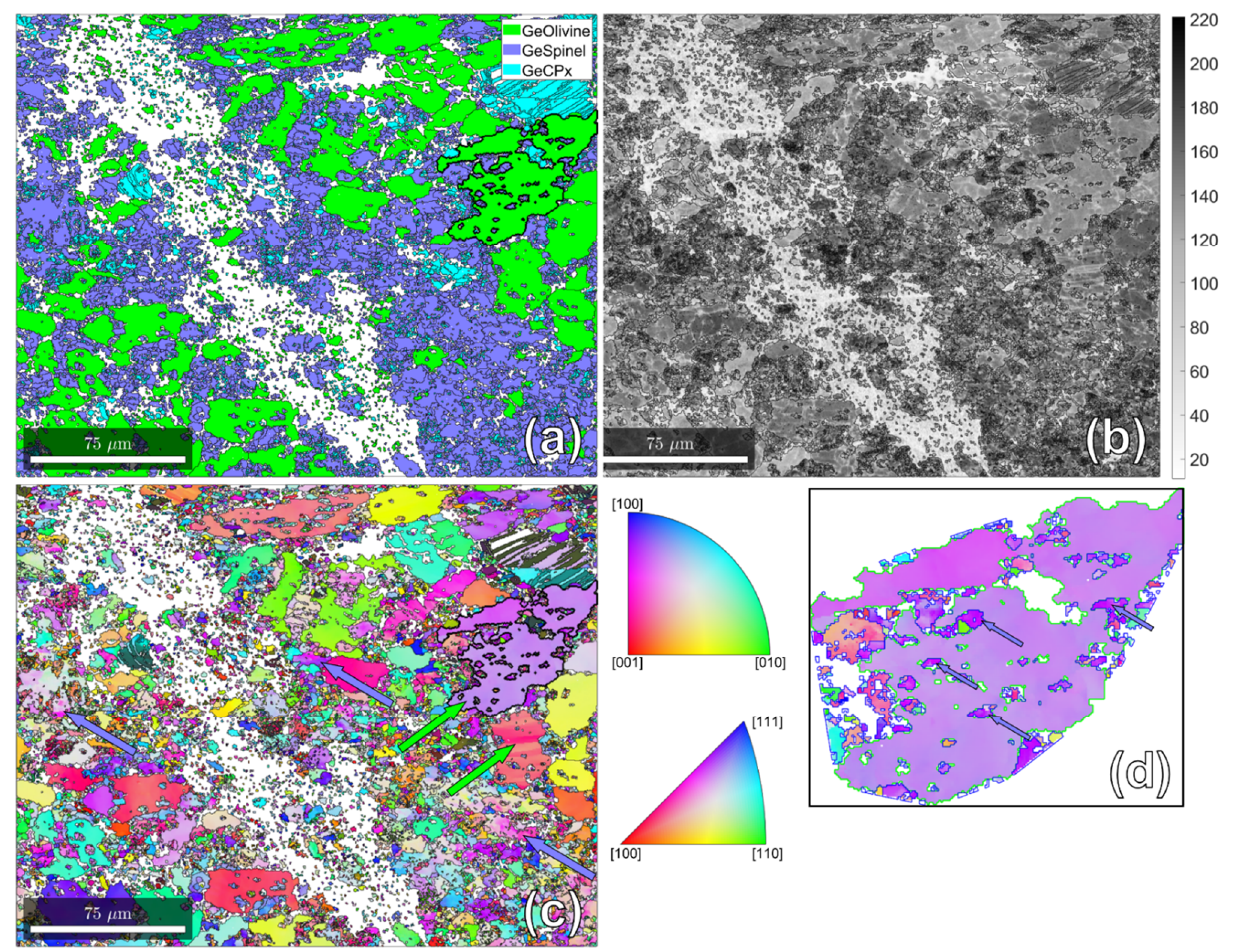
Figure 10. EBSD map of sample G23. ( a ) Phase map with calculated grain boundaries in black. Non-indexed pixels at the center correspond to the main fault of the sample. Large amounts of reaction (i.e., Ge-spinel) are identified near the fault. ( b ) Band contrast of the same map, i.e., brighter shades indicate lower diffraction strength. The fault corresponds to a region of very weak band contrast due to extreme grain size reduction and large defect concentrations. ( c ) Map showing the orientation of indexed pixels according to the inverse pole figure color scale on the right. Ge-olivine grains appear slightly deformed and, in some cases, present kink bands (green arrows). Ge-spinel grains are smaller but those that grew present high internal strain (blue arrows). The Ge-olivine grain highlighted by the thick black lines and the small Ge-spinel lenses it contains are magnified in ( d ). ( d ) Ge-olivine and Ge-spinel grain boundaries are plotted in green and blue, respectively. This map reveals that Ge-spinel lenses are single crystallographic domains (blue arrows).